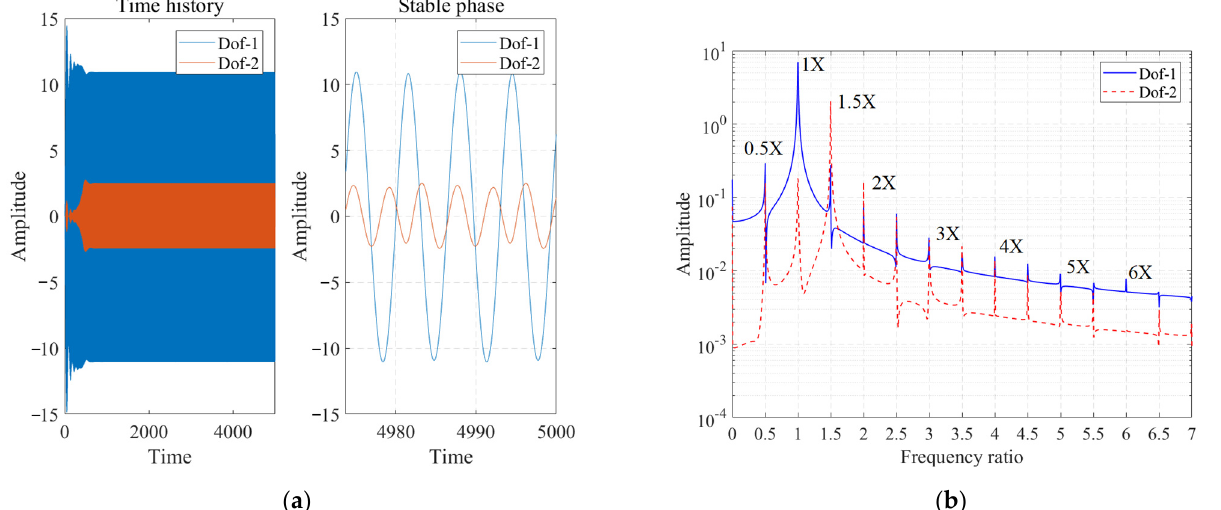
Figure 8. Time history and frequency spectra of the system with an excitation frequency of 0.95: ( a ) time history; ( b ) frequency spectrum.